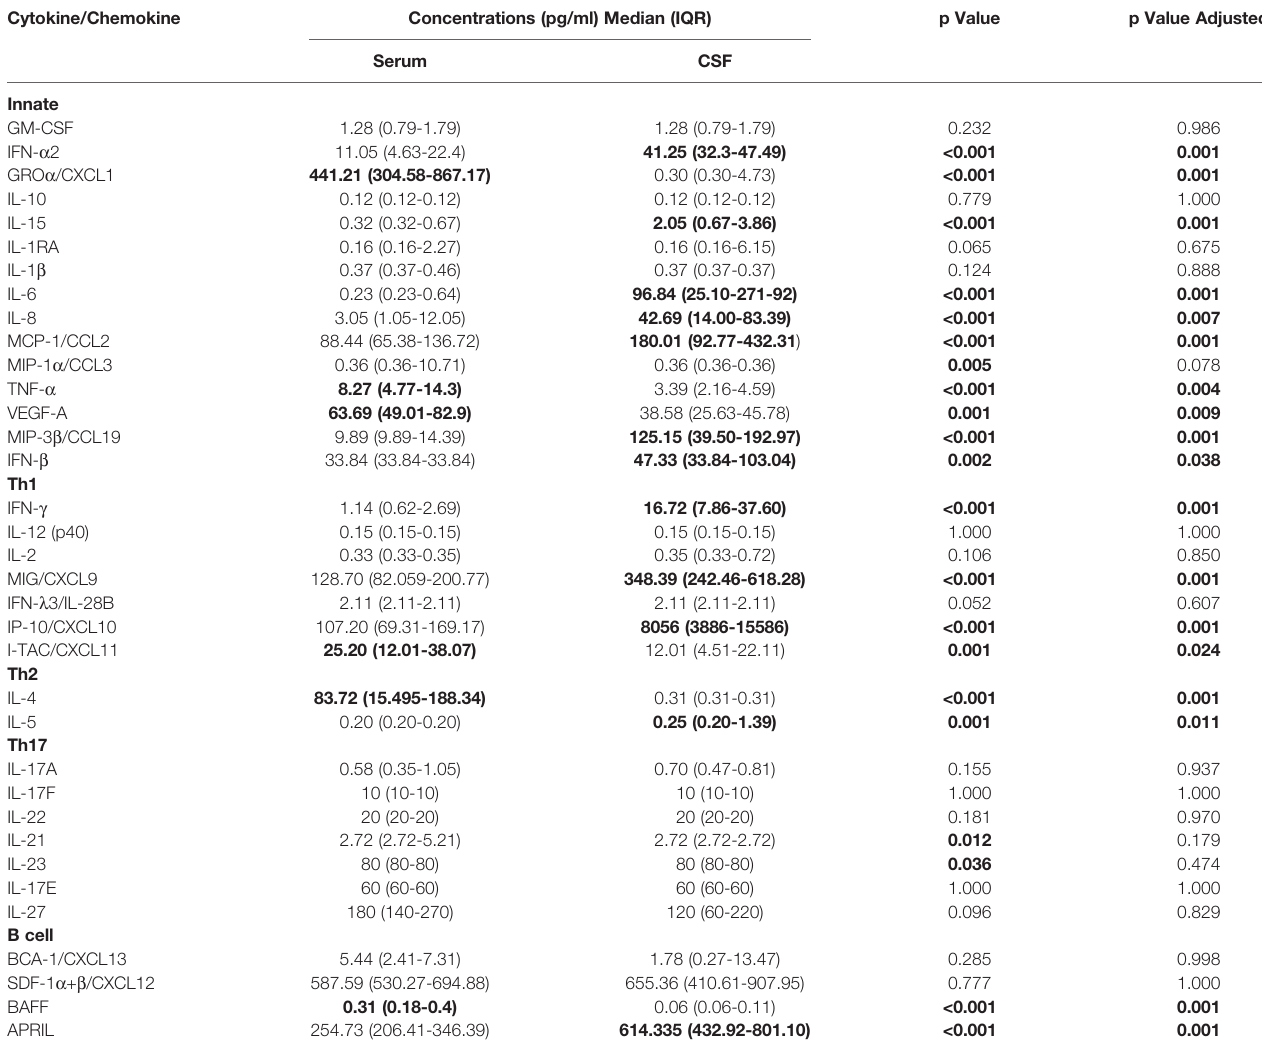
Signi fi cantly higher levels of cytokines/chemokines comparing the two compartments and the corresponding p values are shown in